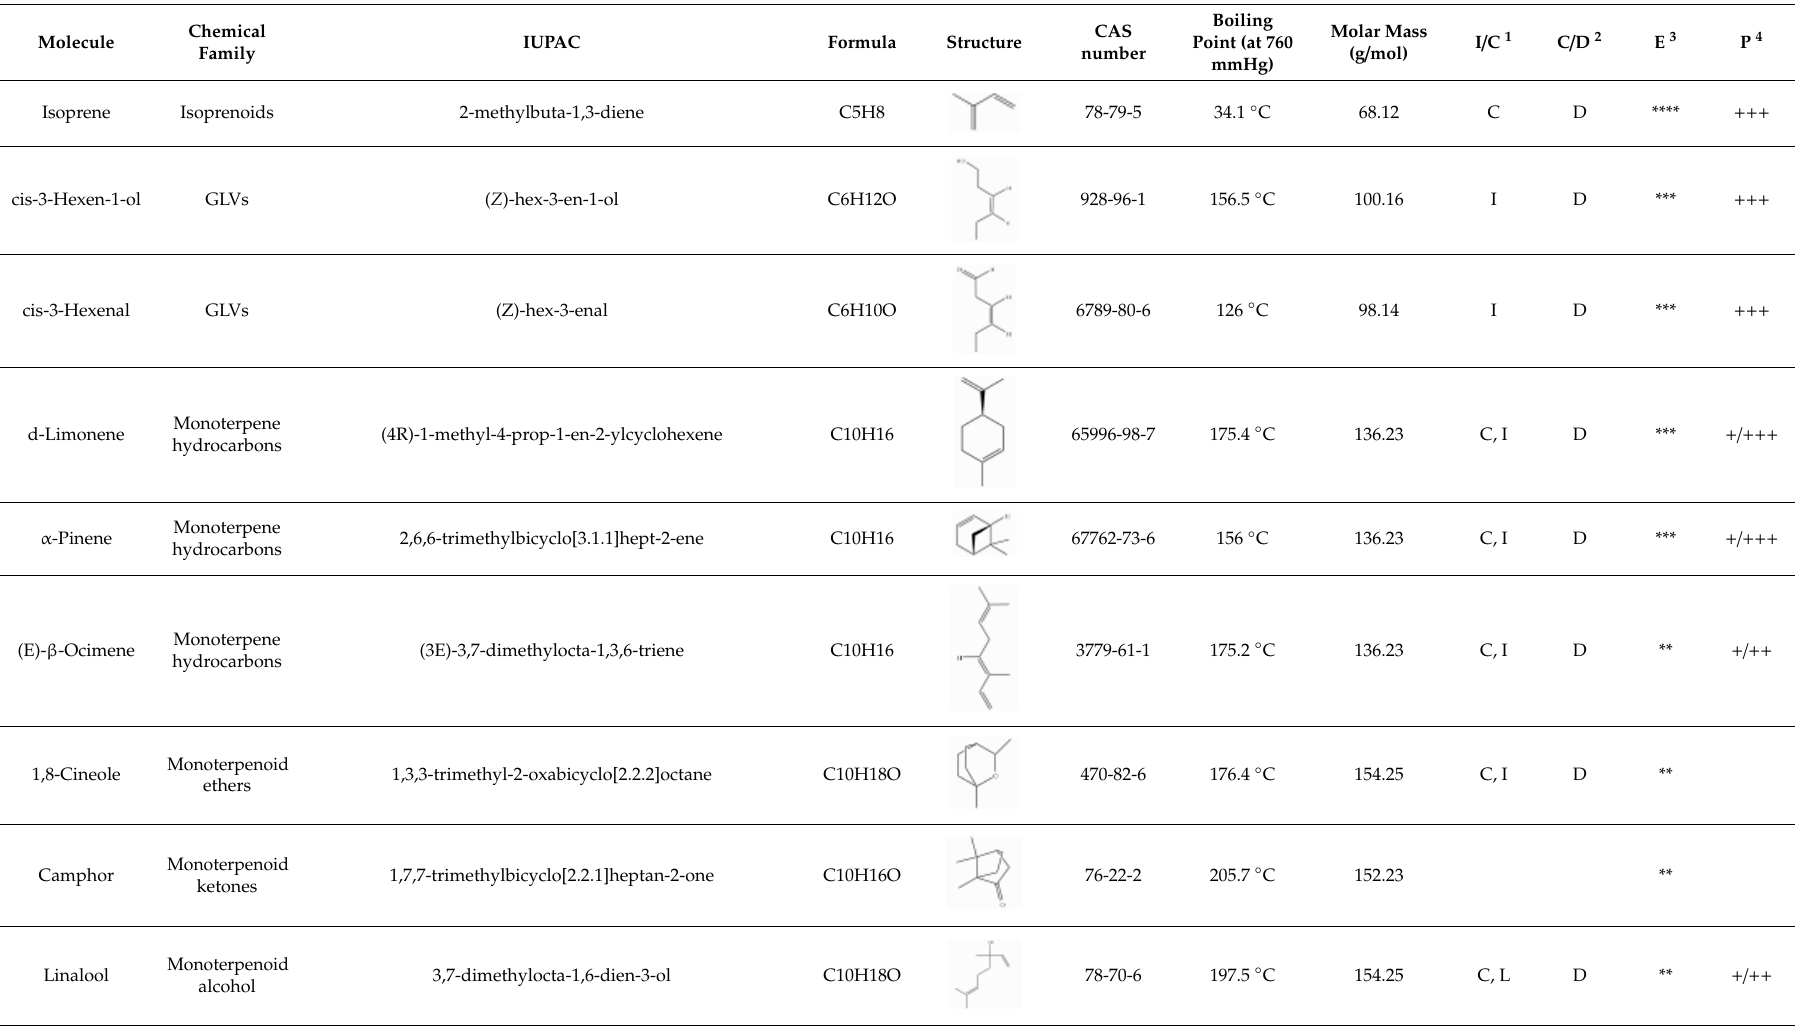
Table 2. Forest BVOCs and their chemical characteristics listed on the basis of the magnitude of emissions (in descending order).